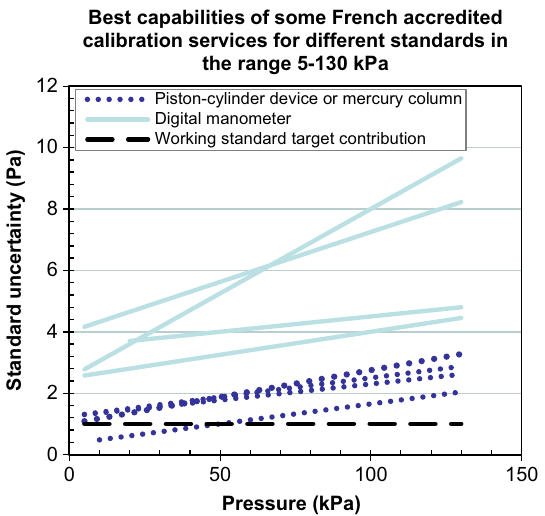
Fig. 1. Uncertainty ( k =1) of some French accredited calibration services. The uncertainty is achieved by means of either a piston/ cylinderorliquidcolumndevice(dottedlines)oradigitalmanometer (solid lines). The maximum uncertainty contribution of the working standard in this study is represented with the dashed line.